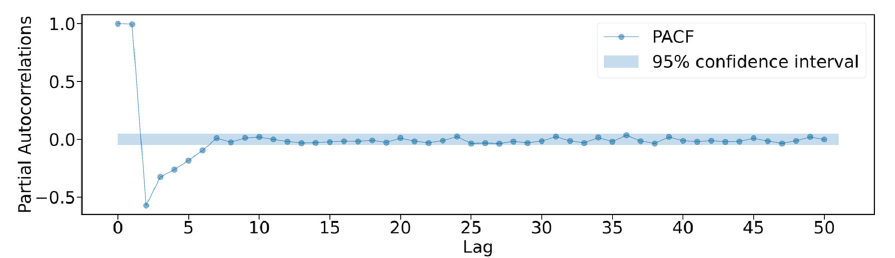
Figure 4. The PACF results of the original observed data.